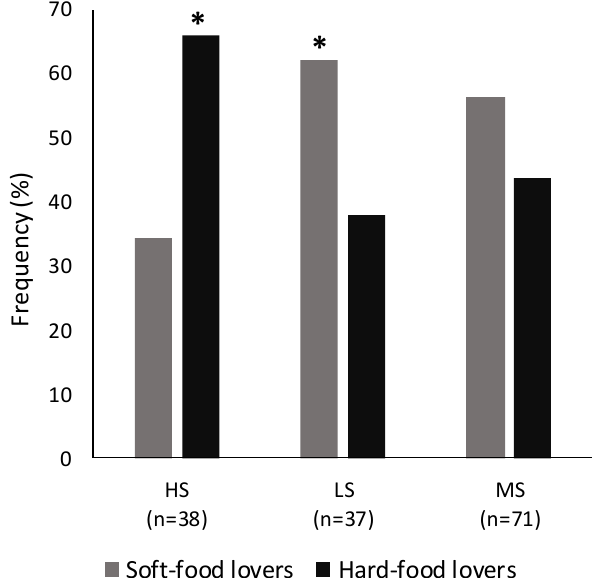
Figure 4. Distribution (%) of soft-food lovers and hard-food lovers in the lowly (LS, n = 37), mod- erately (MS, n = 71) and highly (HS, n = 38) sensitive groups. The bar marked with a star (*) was significantly different ( p ≤ 0.05).